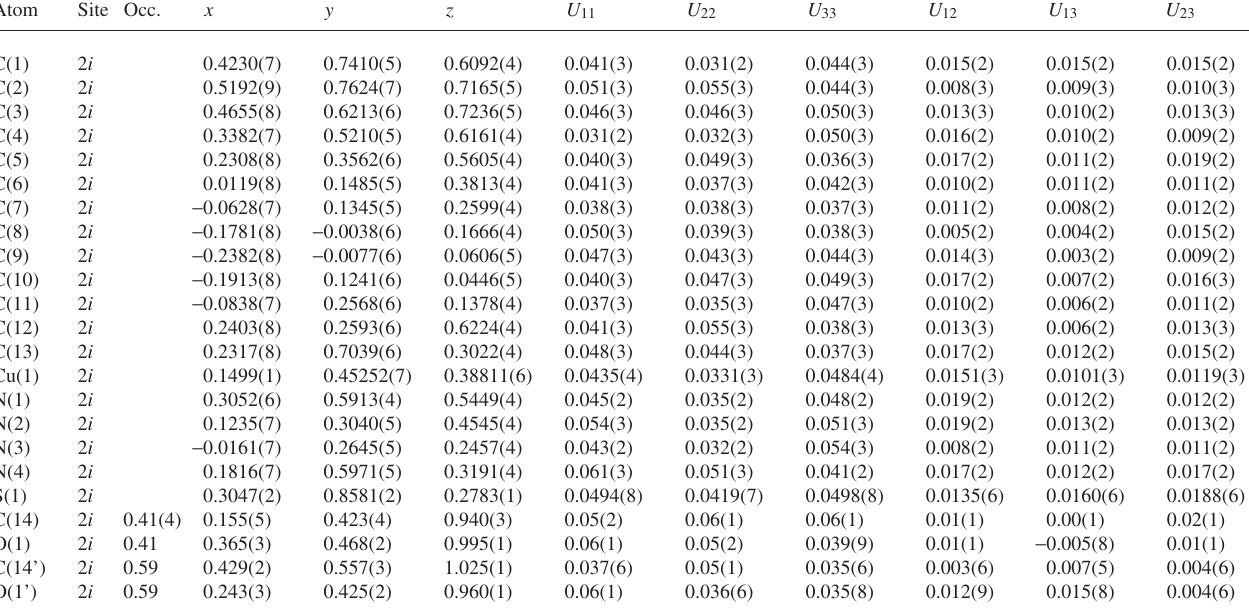
Table 3. Atomic coordinates and displacement parameters (in Å 2 ) .